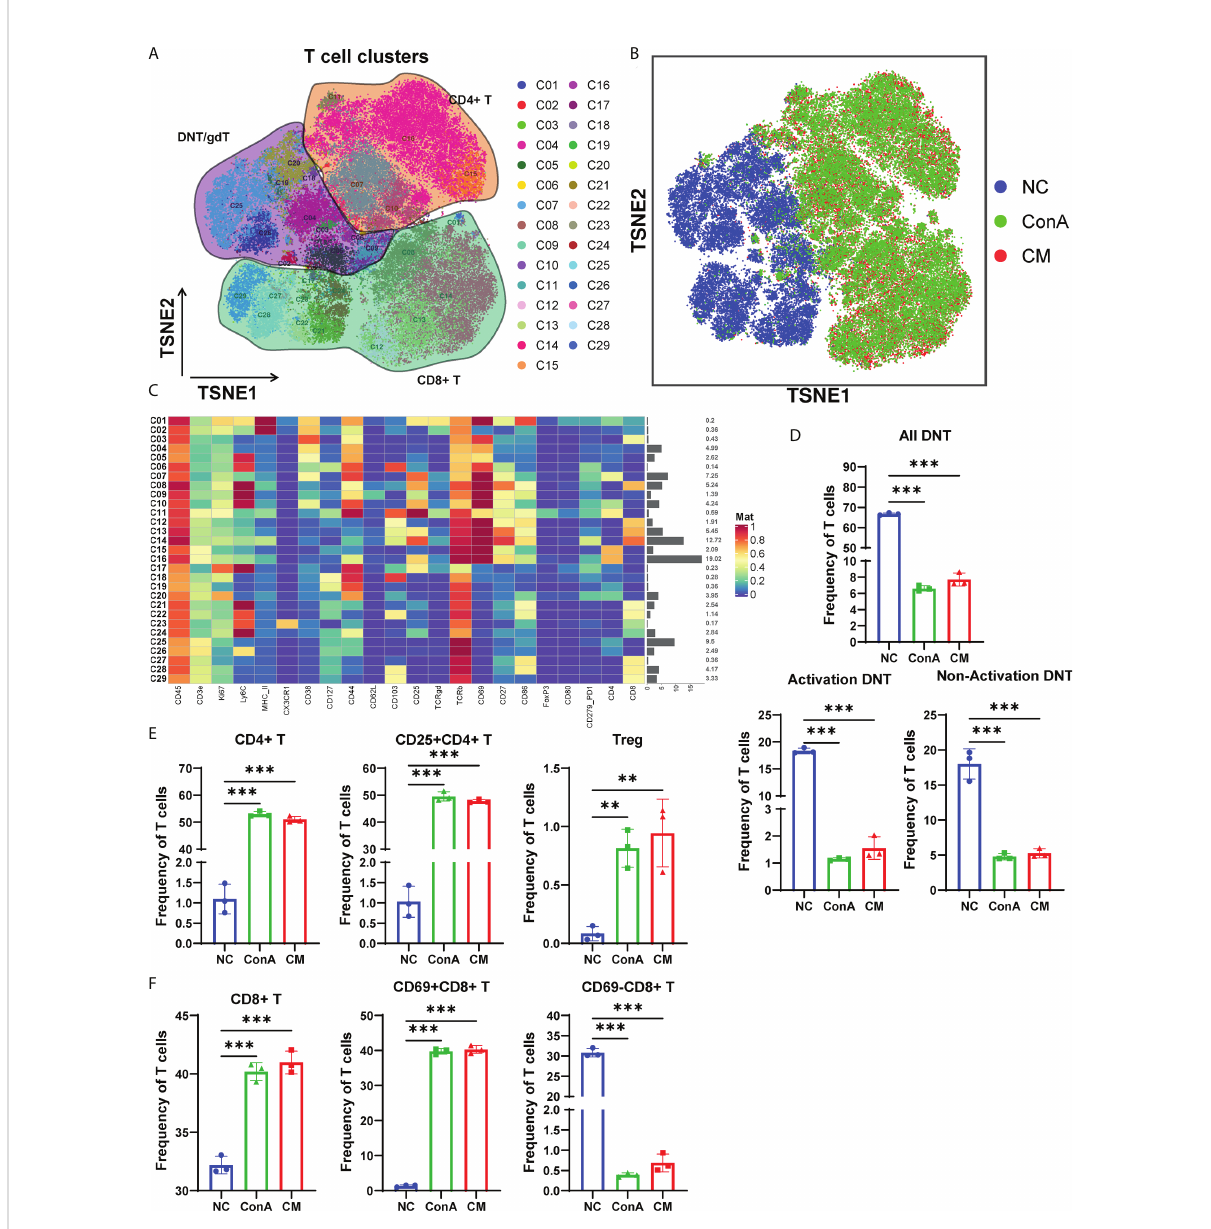
FIGURE 4 Overview of the CyTOF landscape of T cells in liver samples. (A) t-SNE map colored by different subgroups. (B) t-SNE map colored by three groups. (C) Heatmaps of cell surface markers expressed in T-cell subtypes. The proportions of (D) DNT; (E) CD4 + , CD25 + CD4 + , and Treg; and (F) CD8 + , CD69 + CD8 + and CD69 − CD8 + T-cell subtypes among the three groups (n = 3 per group; ns, not statistically signi fi cant, ** p < 0.01, *** p < 0.001). Data are presented as mean ±